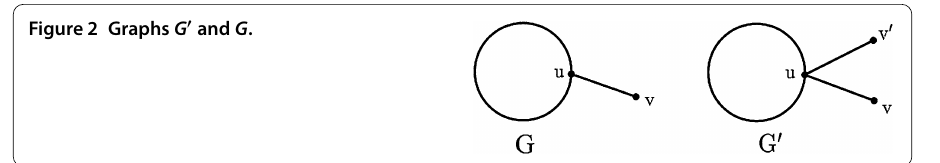
Figure 2 Graphs G (cid:2) and G